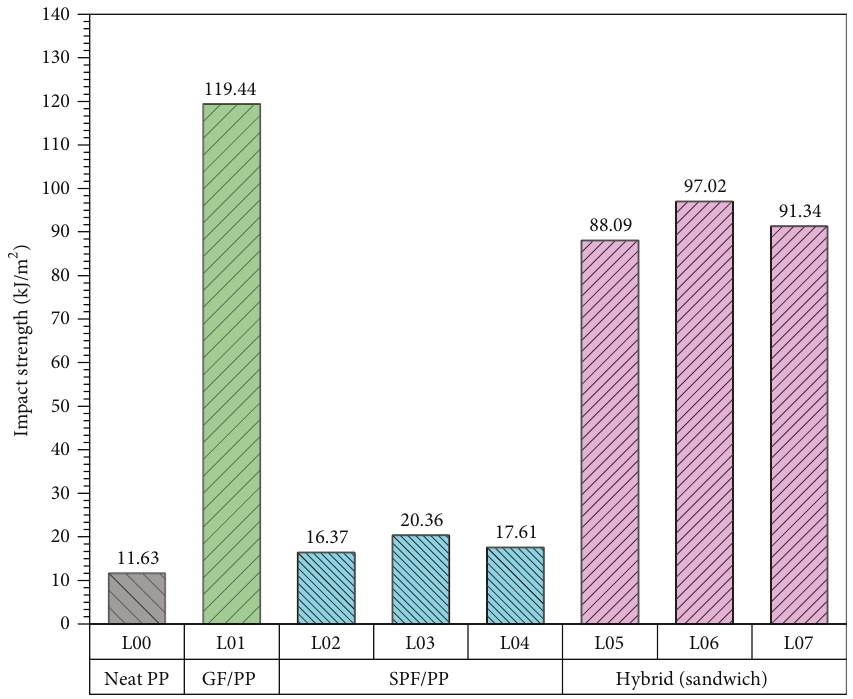
Figure 6: Impact energy of the hybrid and nonhybrid